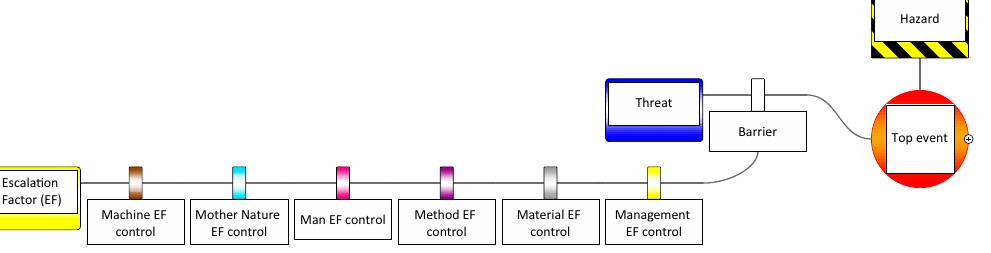
Figure 8. Consequence path with coloured barrier categories.